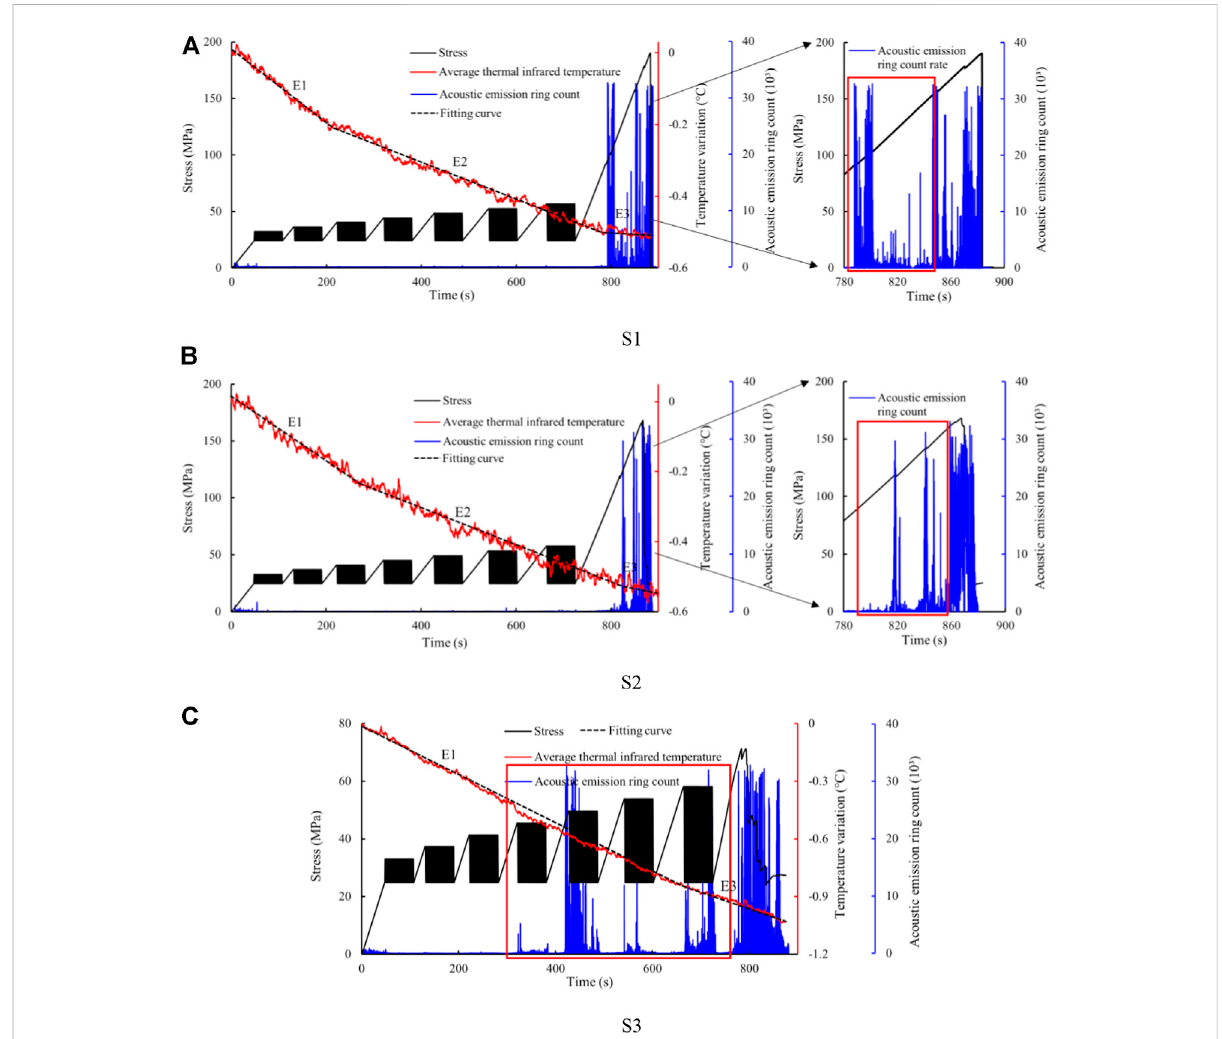
FIGURE 10 Historical images of axial stress, temperature and acoustic emission count of granite samples with time under different freeze-thaw cycles. (A) S1 (B) S2 (C)